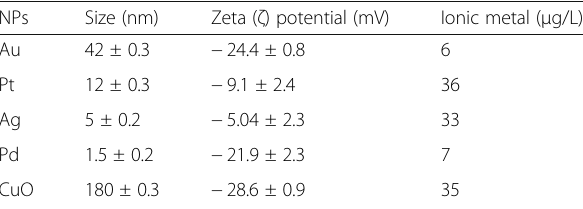
Table 1 Nanoparticle size, zeta-potential and ionic metal concentration determined in TAPx4 medium at a concentration of 20 mg/L. Size and zeta-potential are presented ±standard deviation